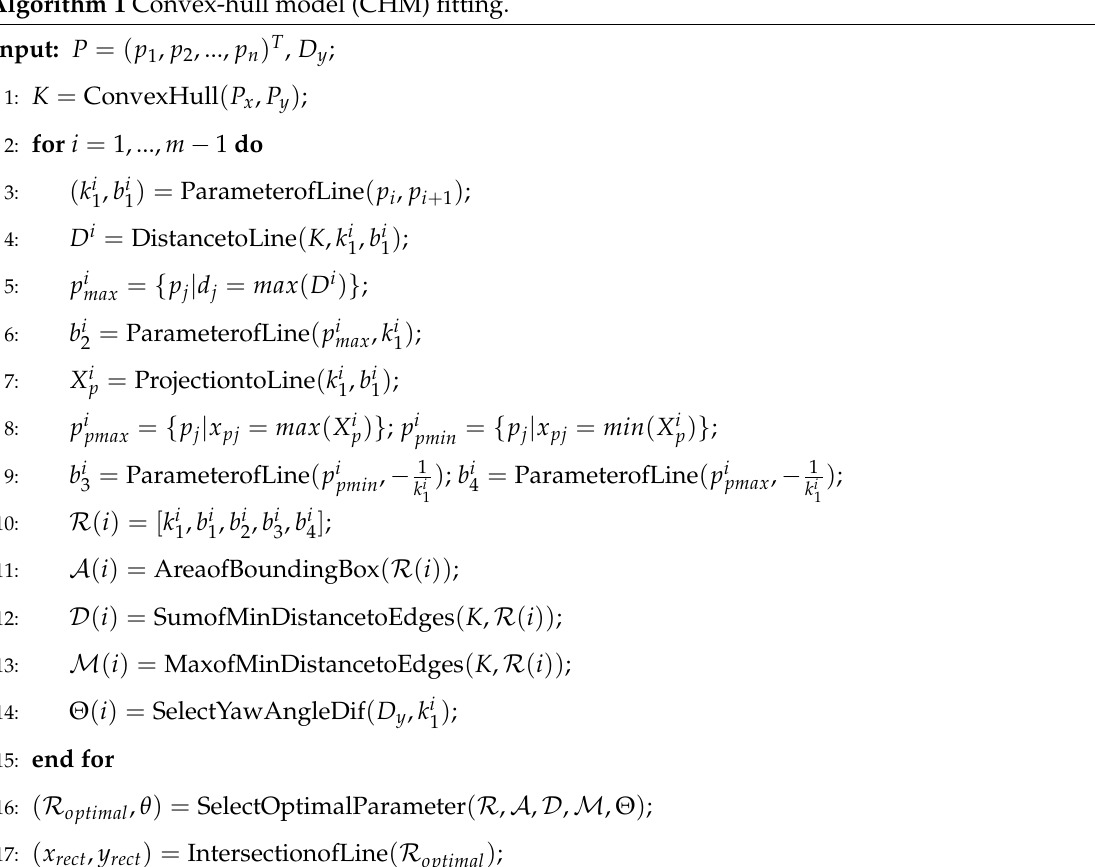
Algorithm 1 Convex-hull model (CHM) fitting.